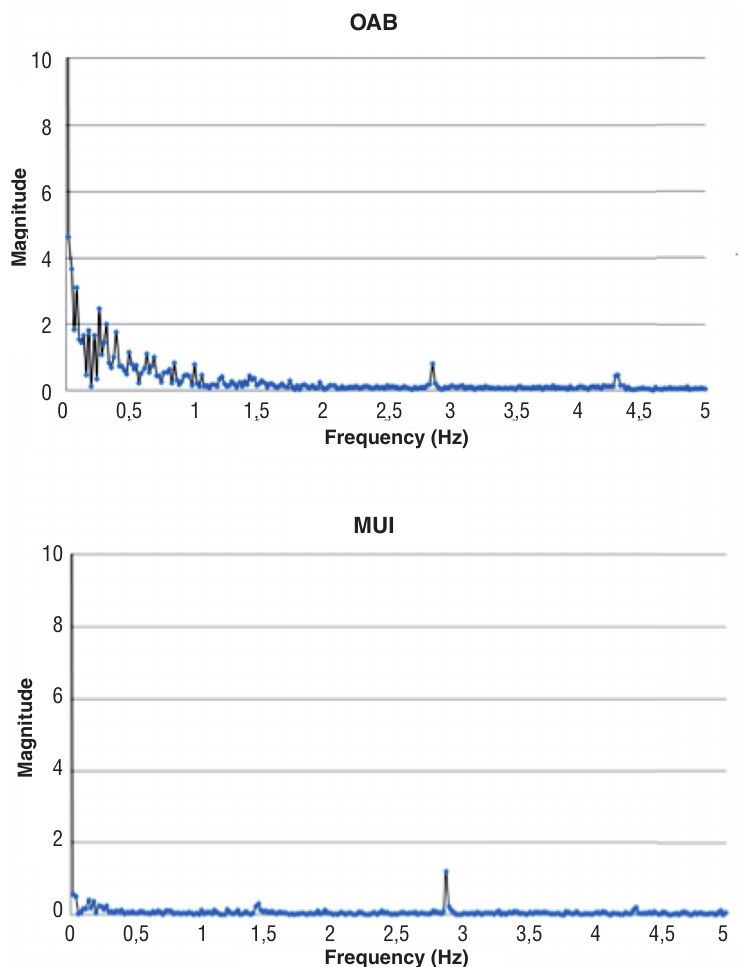
Figure 5 - Representative FFT-Transformation of urethral pressure measures in a patient with OAB (above) and MUI